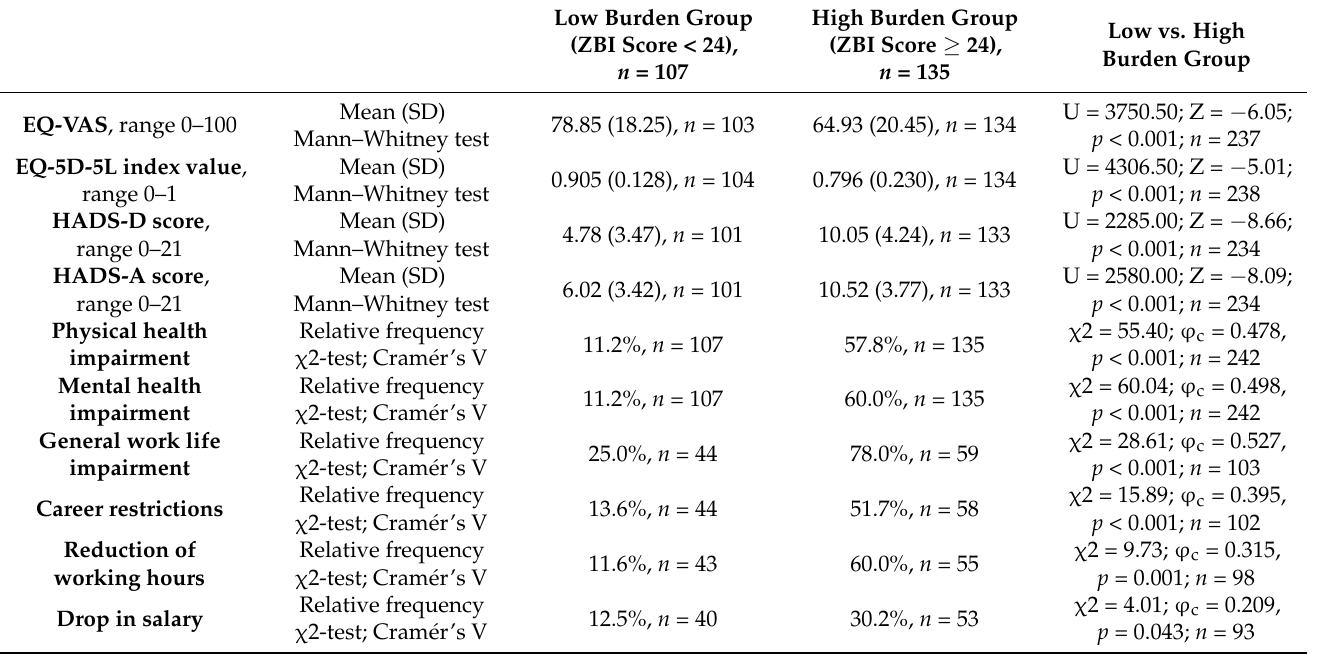
Table 5. Effect comparison between the high and the low burden group: The caregiver burden had effects on the CG’s HRQoL, depression and anxiety, their physical and mental health impairment, general work life impairment, career restrictions, reduction of working hours, and drop in salary. Abbreviations: ZBI = Zarit Burden Interview; n = number; EQ- VAS = EuroQol visual analog scale; SD = standard deviation; HADS-D = Hospital Anxiety and Depression Scale-depression subscale; HADS-A = Hospital Anxiety and Depression Scale-anxiety